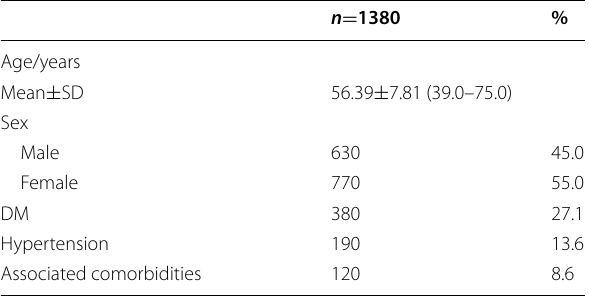
Table 1 Demographic and clinical characteristics of the studied